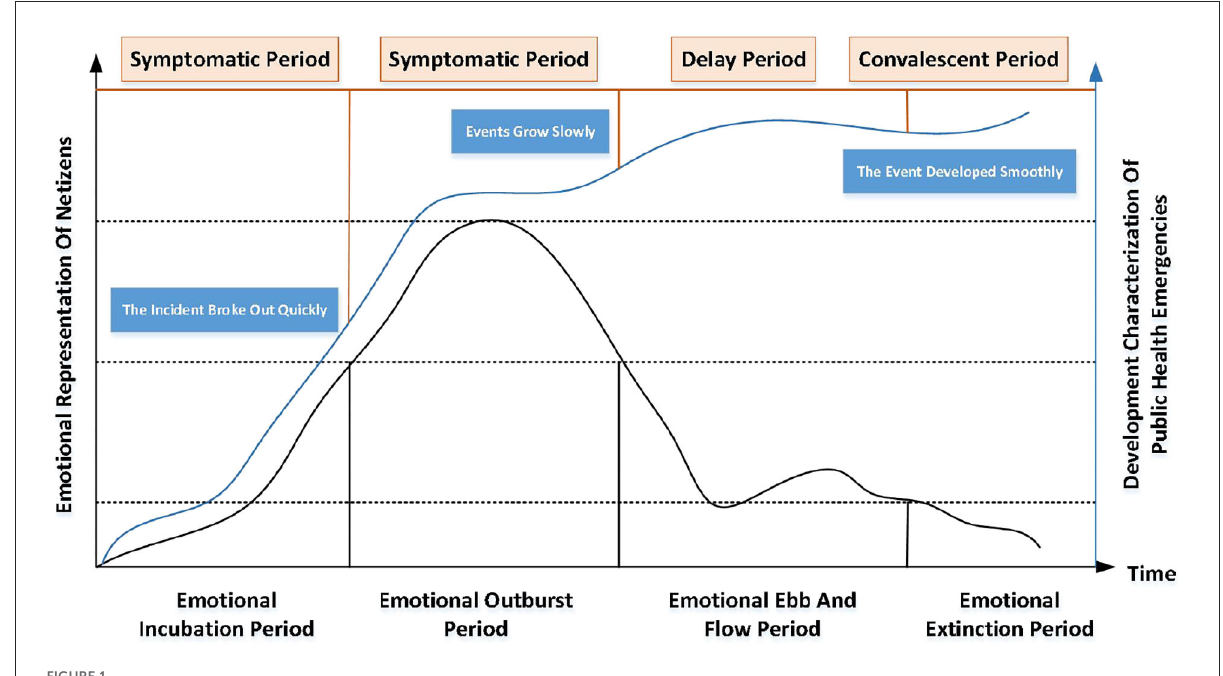
FIGURE1 Evolution stage of public emergencies (Ren, K. et al.,